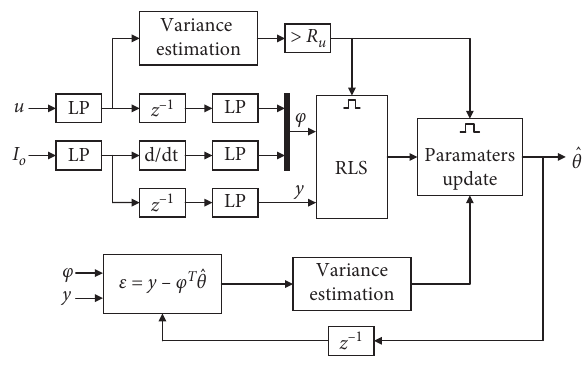
Figure 5: The block diagram of